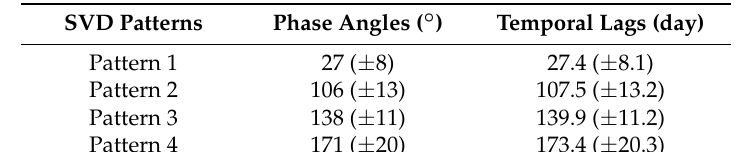
Table 1. Mean phase angles ( ± std) and temporal lags ( ± std) over the regions for the four patterns in a period of 365 days.